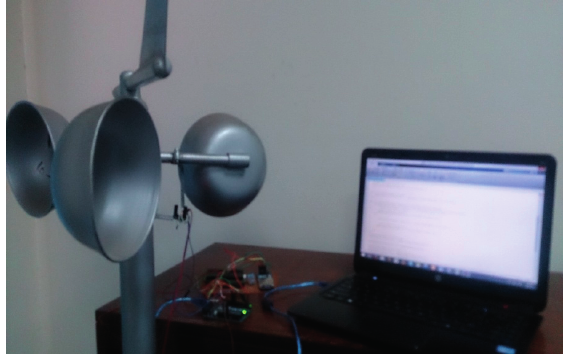
Figure 6. Experimental setup.